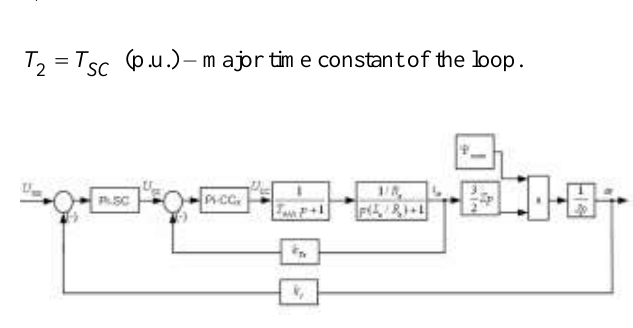
Figure 8. Structure diagram of speed loop tuned on